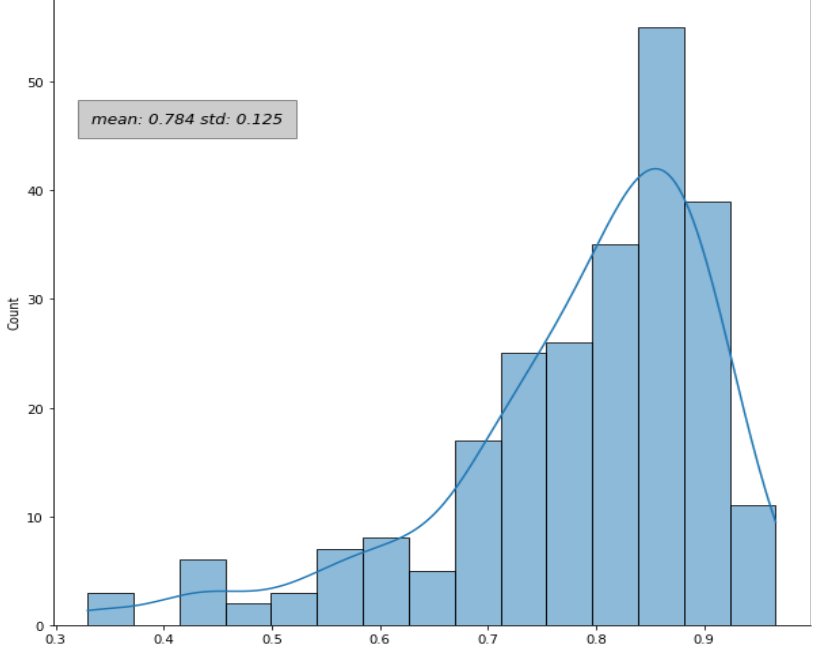
Figure 4. Distribution of the DICE coefficient. The DICE coefficients were evaluated for the patients in dataset A by comparing the automatic and the manual contours in configuration #12. The plot refers to the results after the application of the post-processing and the “radiologist simulation” steps.